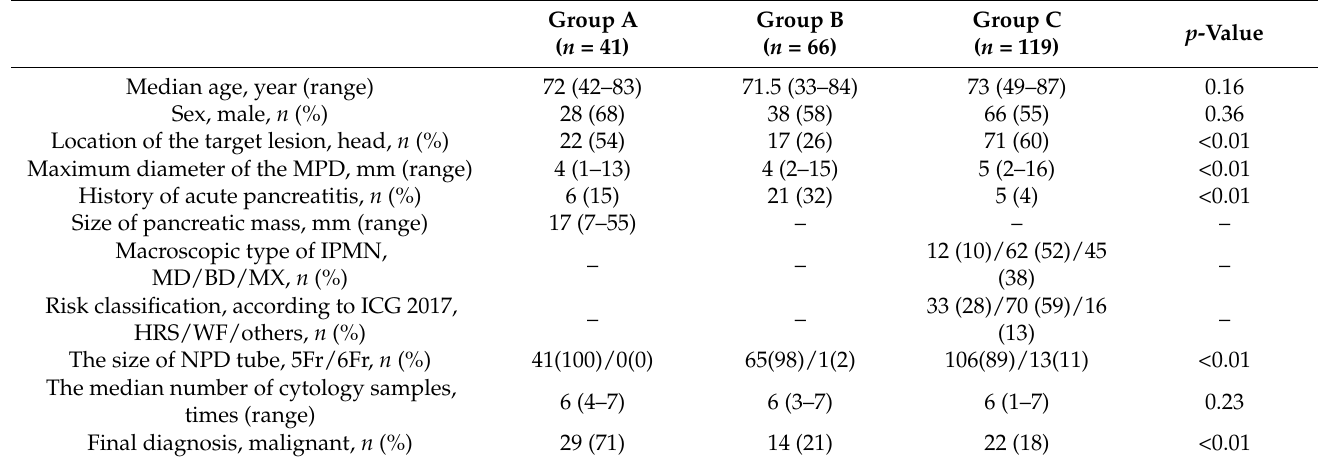
Table 1. Baseline patient characteristics of the PC and IPMN groups.